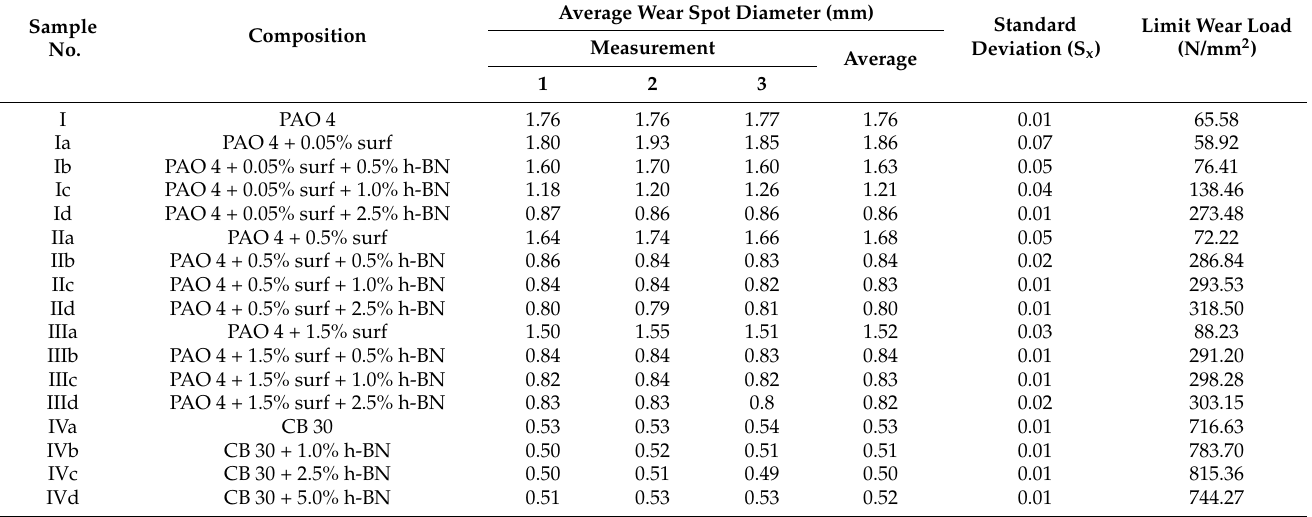
Table 6. Average wear spot